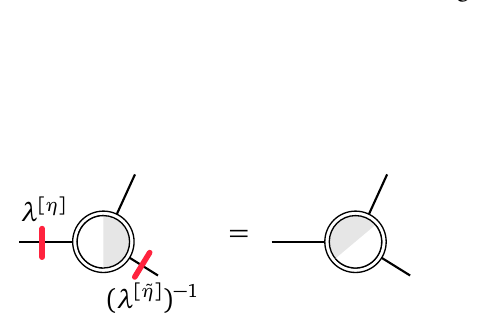
Figure 31: (a) Practical installation of the canonical gauge. (1) The gauge center (always red) of a TN in unitary gauge is SVD-decomposed. Starting with the nodes adjacent to the center, we perform the following steps (resembling a higher-order SVD [ 186 ] ): (2) Absorb unitary matrix and singular values from parent link, (3) perform SVD with respect to a first child link, (4) re-absorb singular values, (5) repeat previous two steps on remaining child links. The final tensor (without the unitaries on the child links) is now in canonical gauge. (b) Comparison of the final and the initial tensor allows us to recover the definition of the canonical gauge.